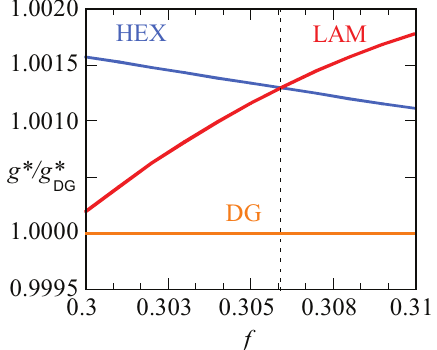
Figure 12. Free energy density of HEX (blue) and LAM (red) phases divided by the free energy density ) as a function of composition f for the system N = 300, χ N = 120. Stable of DG (orange) ( g ∗ / g ∗ DG > 1. HEX and LAM phases are phase occurs when the corresponding phase has the value of g ∗ / g ∗ DG stable in left and right regions, respectively, that are separated with a dotted